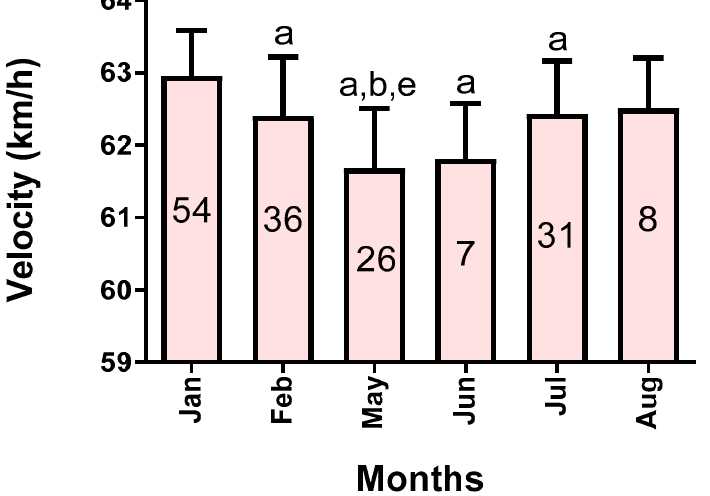
Figure 1. Running speed values grouped by months. The number of runs by group is presented in the middle part of each bar. Data are presented as mean and standard deviation. a = different from January, b = different from February, e = different from July, with a p -value < 0.05.